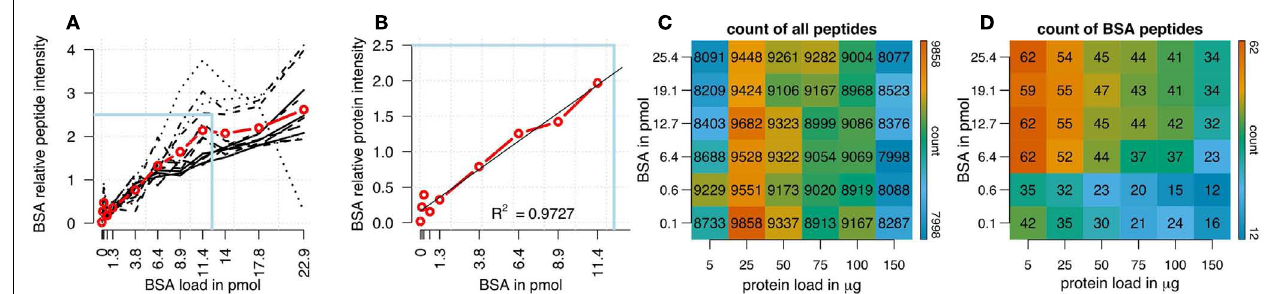
peptides is shown, in a matrix combining different amounts of BSA loads (120fmol to 25.6pmol) with different total protein loadings (5 – 150 µ g). (C) Count of identified plant peptides was dependent on sample complexity with an optimum at 25 µ g of protein load.The amount of spiked BSA amount had almost no impact on identified plant peptides. (D) Count of BSA peptides was affected by total protein load as well as BSA load. Optimal combinations were 5 and 25 µ g of total protein spiked with 1–4pmol of BSA.The color bar indicates the color code for low and high counts of peptides from blue to red.